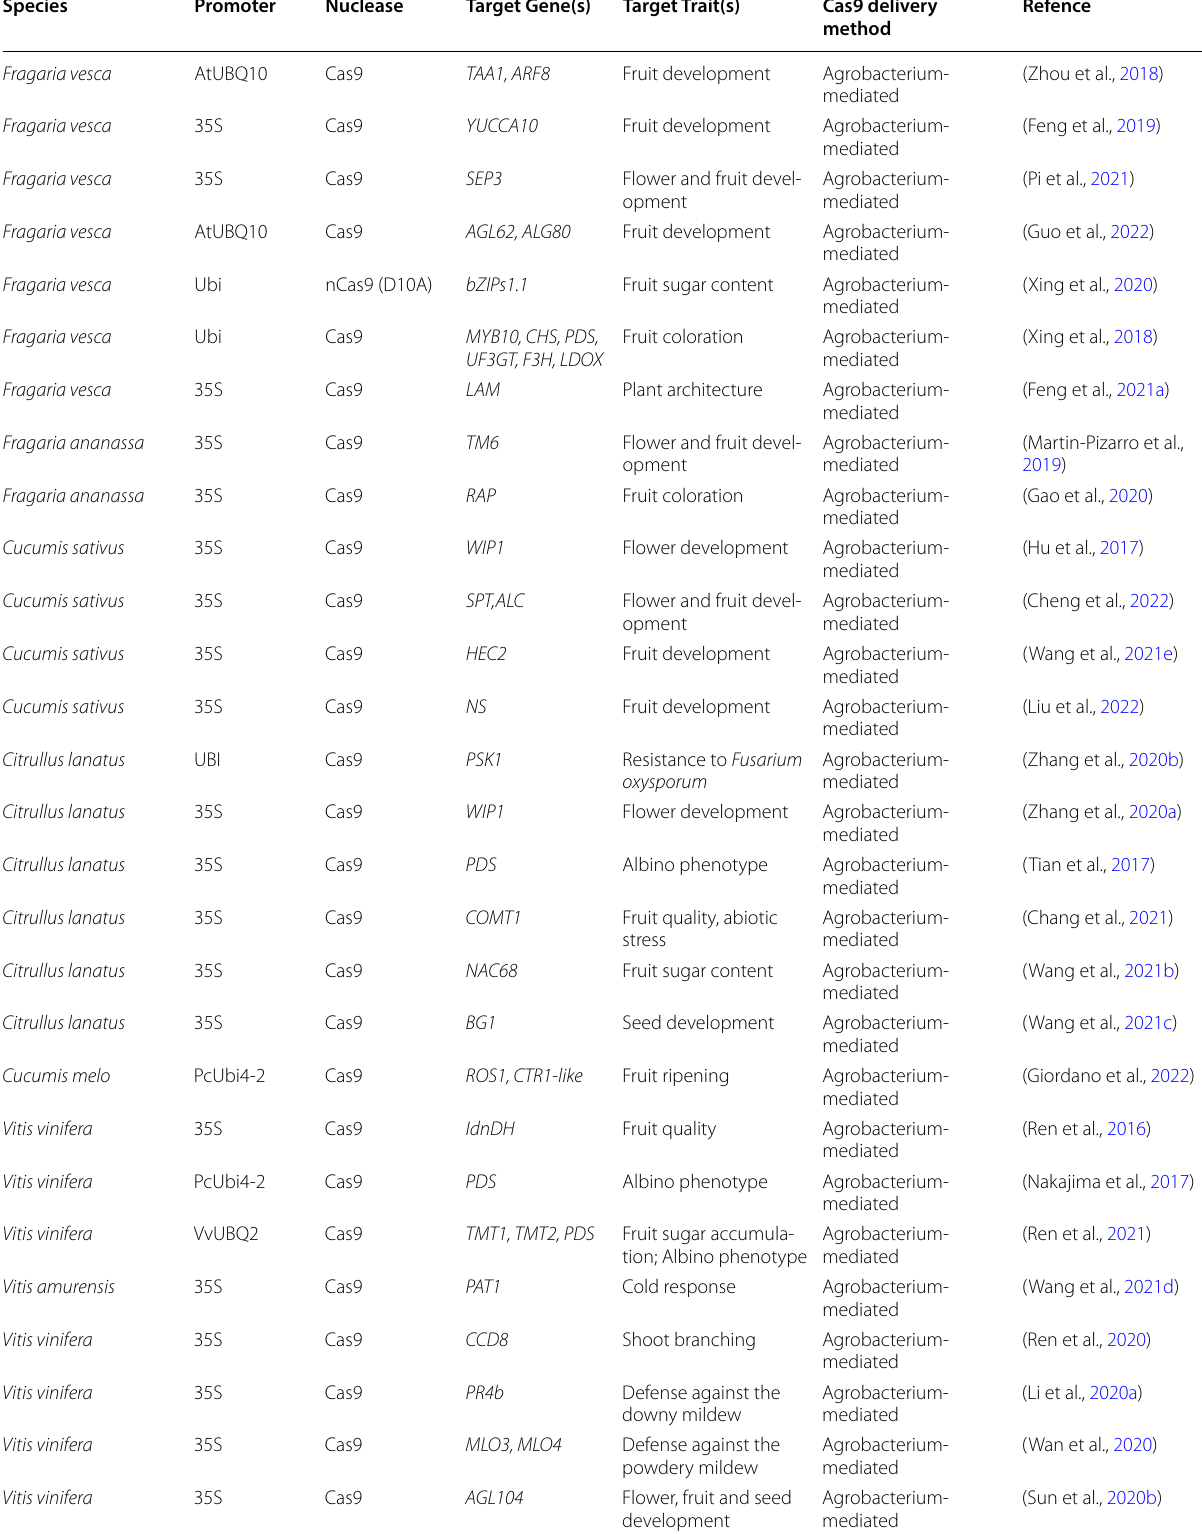
Table 1 Recent advances of CRISPR/Cas genome editing in economically important fruit crops